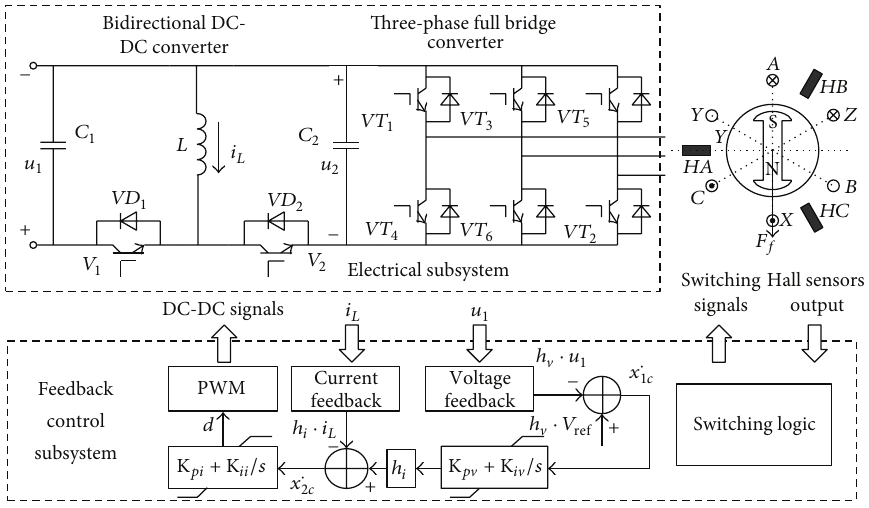
Figure 4: Schematic diagram of power drive